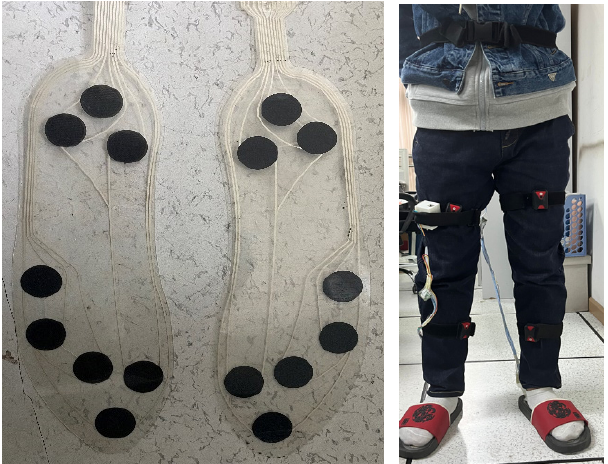
Figure 1. Pressure insole ( Left ). It contains eight different positions of force-sensing force resistance for measuring vGRF in various situations. IMU ( Right ). It contains an accelerometer, gyroscope, and magnetometer used to capture human movement data.